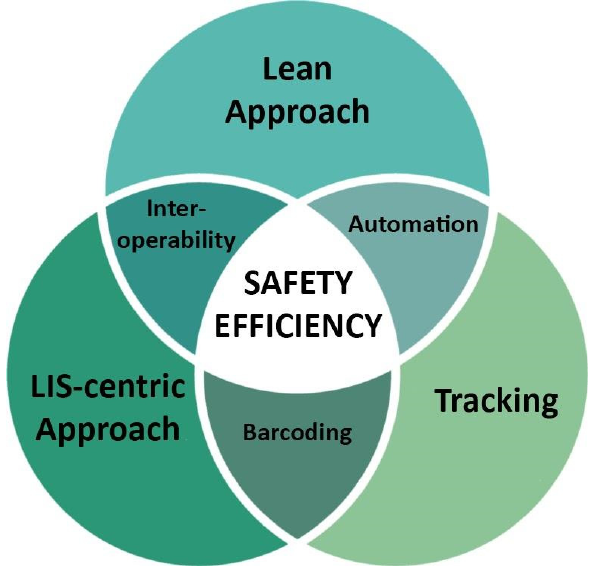
Figure 8. The importance and relationship of the main points required for the development of a reliable, sustainable and safe digital pathology workflow.